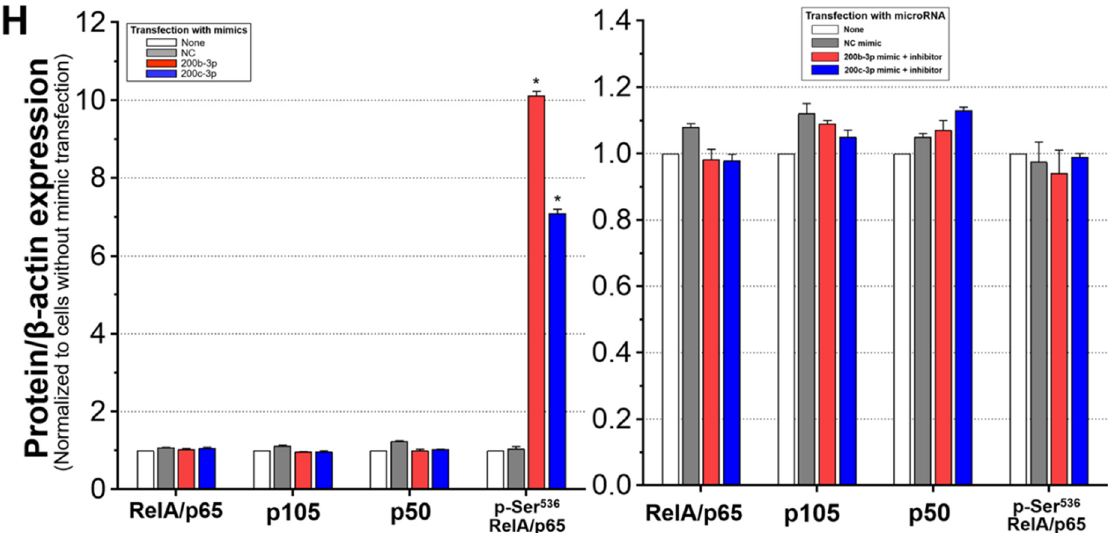
Figure 6. Phosphorylation of the RelA/p65 subunit on Ser 536 is caused by IE proteins, and the down ‐ regulation of IE proteins in response to the upregulation of miR ‐ 200b ‐ 3p and miR ‐ 200c ‐ 3p is associ ‐ ated with increased levels of p ‐ Ser 536 RelA/p65. ( A ) The levels of RelA/p65 and p ‐ Ser 536 RelA/p65 proteins were measured at the indicated time points by immunoblotting. HFF ‐ 1 cells infected with the Towne strain of HCMV at an MOI of 0.1. ( B ) IE72 or IE86 plasmids were transfected into U373MG cells (1 × 10 6 /well; 6 ‐ well plates) that were lysed 2 days later. Total protein from pelleted cells was analyzed by immunoblotting using monoclonal antibodies (mAb) against IE72 (72 kDa), IE86 (86 kDa), RelA/p65 (RelA/p65, 65 kDa), phosphorylated RelA/p65 (Ser 536 ) (p ‐ Ser 536 RelA/p65, 65 kDa), and β‐ actin. Negative and positive controls comprised cells transfected with EGFP plasmid and incubated with TNF ‐α (10 ng/mL) for 30 min, respectively. HFF ‐ 1 cells infected with the HCMV Towne strain and transfected with the miR ‐ 200b ‐ 3p, miR ‐ 200c ‐ 3p mimic or inhibitor, and NC mimic (each of 300 ng). HFF ‐ 1 cells that were p ‐ Ser 536 RelA/p65 ‐ positive were assessed by flow cytometry ( C ) and fluorescence images ( E ) obtained at 2 dpi. Cell counts were normalized to NC mimic ‐ trans ‐ fected cells ( D ). Fluorescence images without mAb were stained with polyclonal IgG secondary Ab. The levels of RelA/p65, p ‐ Ser 536 RelA/p65, and p105/p50 proteins were measured by immunoblotting in HFF ‐ 1 cells transfected with miR ‐ 200b ‐ 3p/miR ‐ 200c ‐ 3p mimics and infected with Towne strain ( F ) or with miR ‐ 200b ‐ 3p and miR ‐ 200c ‐ 3p inhibitors immediately thereafter ( G ). ( H ) Band intensity in immunoblots. Box plots show values obtained from triplicate experiments ( D , H ). Upper lines and error bars indicate means and SEM, respectively. * p < 0.001 vs. cells transfected with NC mimic. MiR ‐ 200b ‐ 3p and miR ‐ 200c ‐ 3p affected IE72 and IE86 expression after binding to the